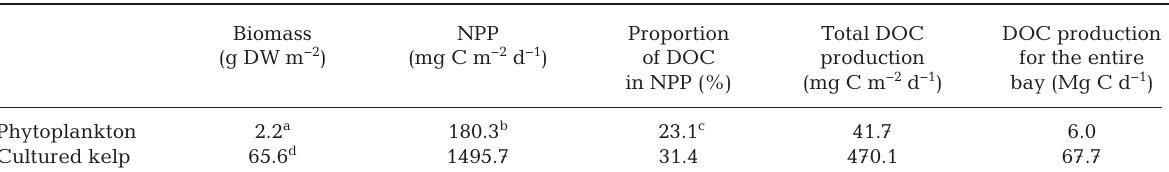
Table 2. Calculated dissolved organic carbon (DOC) production of phytoplankton and cultured kelp in Sanggou Bay. NPP: net primary